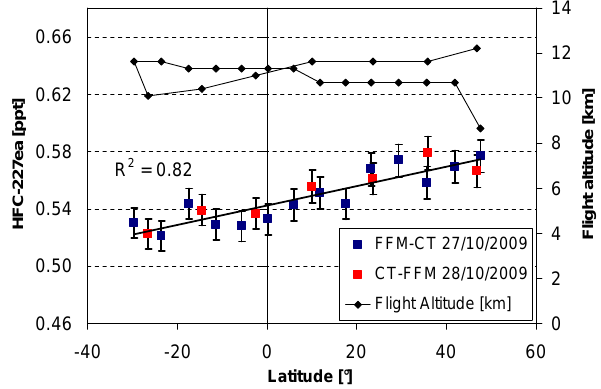
Fig. 3. Upper tropospheric mixing ratios of HFC-227ea as a func- tion of latitude in air samples collected on board a Lufthansa aircraft during two flights from Frankfurt (Main), Germany (FFM) to Cape Town, South Africa (CT) and back. Two samples were collected at potential vorticity values indicating air from the tropopause re- gion, but due to the long stratospheric lifetime of HFC-227ea this has little influence on the correlation.